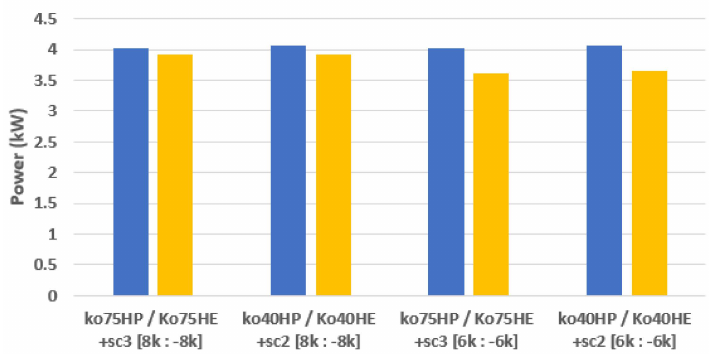
Figure 12. RMS battery power for a single source (blue) and a HESS